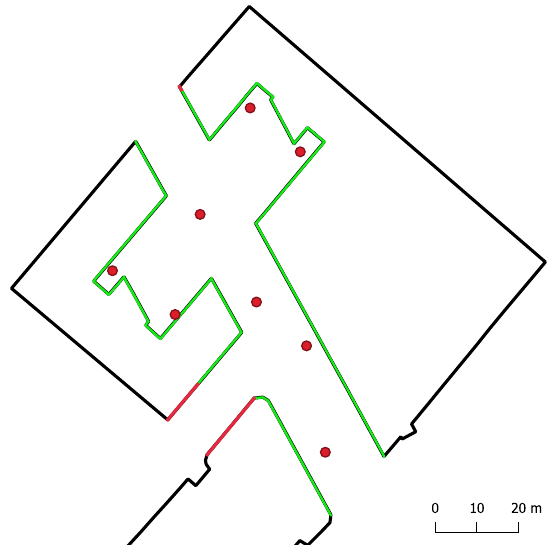
Figure 6. Scanner positions chosen by an expert and the corresponding visible (green) and not visible parts (red) of the buildings considering the scanner related